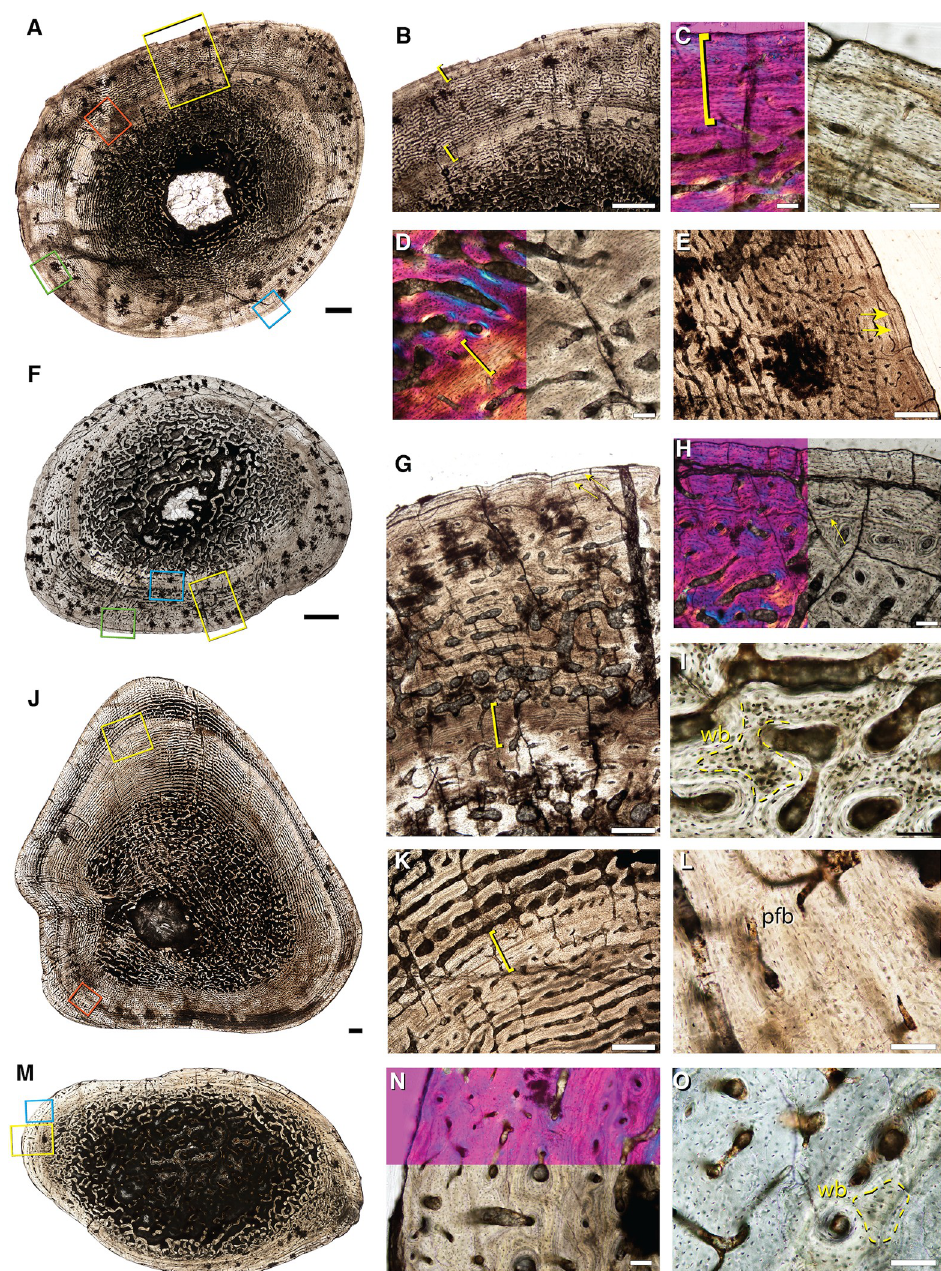
Fig 5. Bone histology of associated elements of Lystrosaurus sp. representative of Size Class III. A , femur (IVPP V 26548a) has two growth marks. B , a deep, mid-cortical annulus (yellow box in A ; lower yellow bracket in B ), avascular lamellar tissue makes up the second growth mark (upper yellow bracket in B ). C , magnification of peripheral lamellar tissue, left panel reflects blue box in A , right panel reflects green box in A . D , first (osteologically deeper) annulus (yellow bracket) in plane and cross-polarized light with a lambda filter. E , magnification of blue box in A of outer cortical growth mark that varies in thickness around the periphery of the thin section, here consisting of two LAGs (yellow arrows in E ). F , associated fibula (IVPP V 26548c) highlights a similar arrangement of deep and more superficial growth marks consisting of, at times, numerous layers of lamellar tissue in an annulus. G , magnification of yellow box in F showing two growth marks; annulus (yellow bracket) and peripheral LAGs (yellow arrows). H , magnification of green box in F showing variation in the outer growth mark such that in some regions it appears as a thicker region of lamellar tissue with one cross-cutting LAG. I , high magnification image of the associated tibia (IVPP V 26548b) showing the presence of woven-fibered bone between primary osteons within the middle cortex. J ,